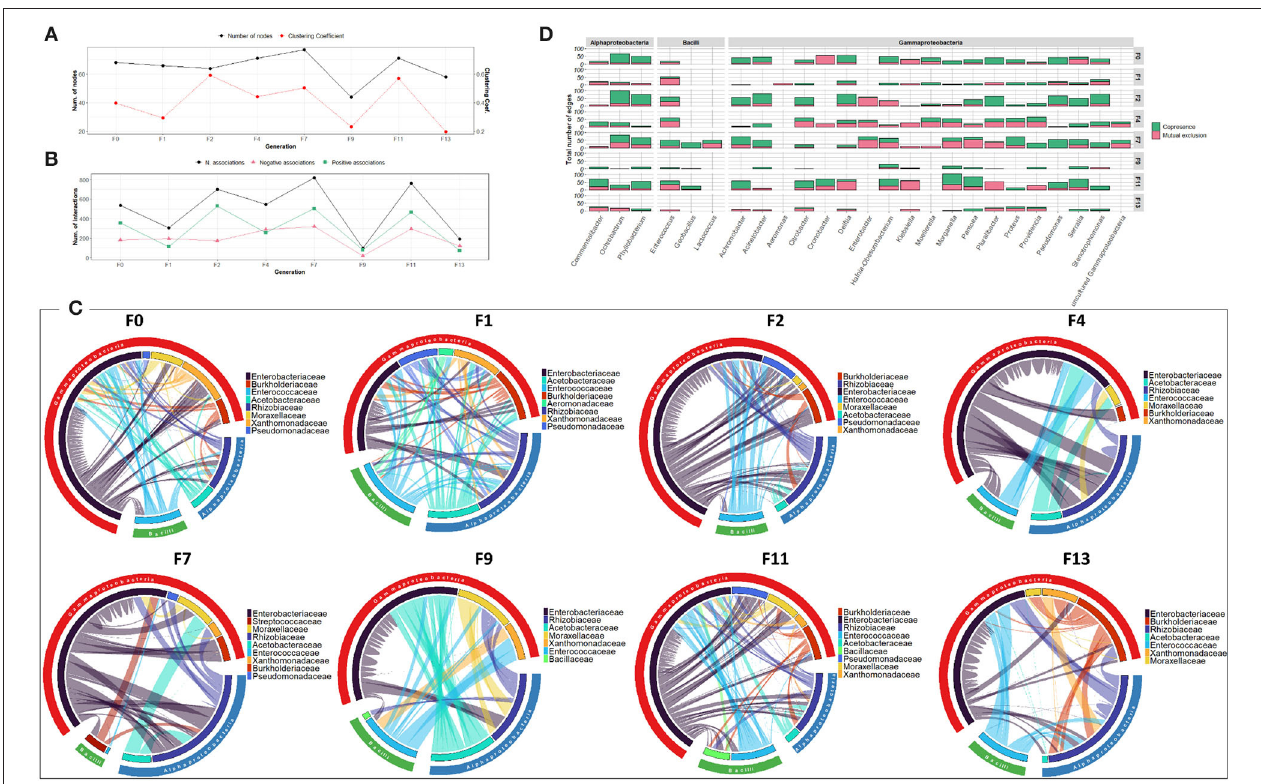
FIGURE 7 | Bacterial community network within the guts of C. capitata adult during laboratory adaptation of wild population. (A) Total number of nodes and clustering coefficient. (B) Total number of negative (red) and positive (green) associations. (C) Chord diagram displaying direct relationship between OTUs at the family level. The size of the ribbon is proportional to the weight of the association between the OTUs assigned to the respective segments and the color of the ribbon present in the direction of the interaction. (D) Number of positive and negative associations at the genus